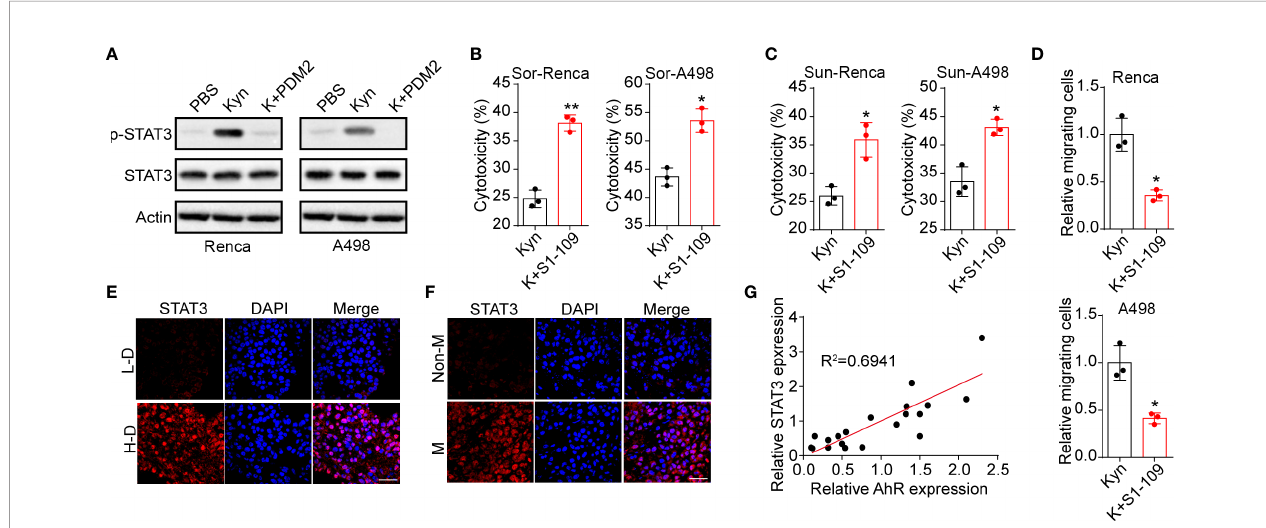
FIGURE 4 | Kyn regulated cells migration and metastasis through AhR/STAT3 signal. (A) The western blotting of phosphorylated STAT3, total STAT3 in Renca/ A498 treated with PBS, Kyn (0.5 m M), Kyn (0.5 m M) combined with PDM2 (1 nM). (B) The cytotoxicity of Sor to Renca/A498 treated with Kyn (0.5 m M) or Kyn (0.5 m M) combined with S1-109 (2 m M). (C) The cytotoxicity of Sun to Renca/A498 treated with Kyn (0.5 m M) or Kyn (0.5 m M) combined with S1-109 (2 m M). (D) The relative migrating cells numbers and representative images of Renca/A498 treated with Kyn (0.5 m M) or Kyn (0.5 m M) combined with S1-109 (2 m M). (E) , Immuno fl uorescence staining of phosphorylated STAT3 in tumor tissues from high degree (H-D) and low degree (L-D) renal cancer patients. The scale bar is 50 m m. (F) Immuno fl uorescence staining of phosphorylated STAT3 in tumor tissues from non-metastatic (non-M) and metastatic renal cancer patients. The scale bar is 50 m m. (G) The correlative analysis of AhR and phosphorylated STAT3 expression in tumor tissues from renal patients. Mean ± SEM, n.s, no signi fi cant difference; *p < 0.05, **p <